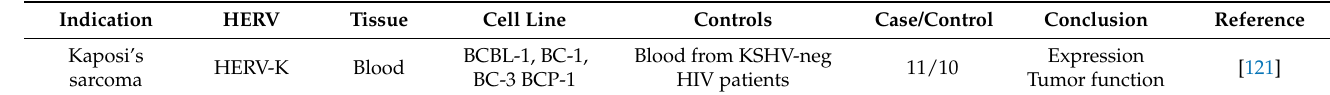
Table 13. HERV protein expression in